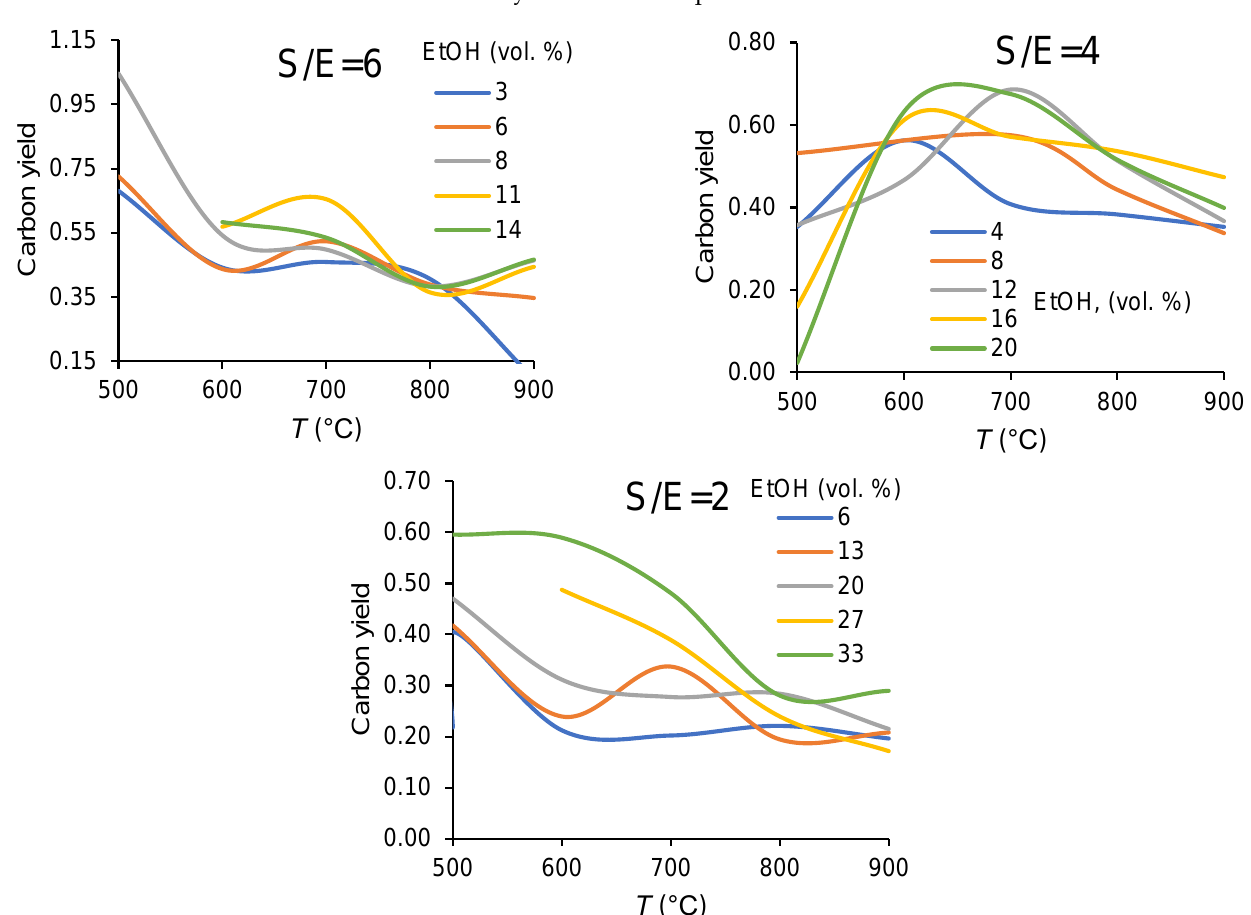
Figure 3. Dependencies of carbon yield in ethanol steam reforming in CMR at different ethanol concentrations (in vol.%) on temperature and the steam-to-ethanol molar ratios in the feed.